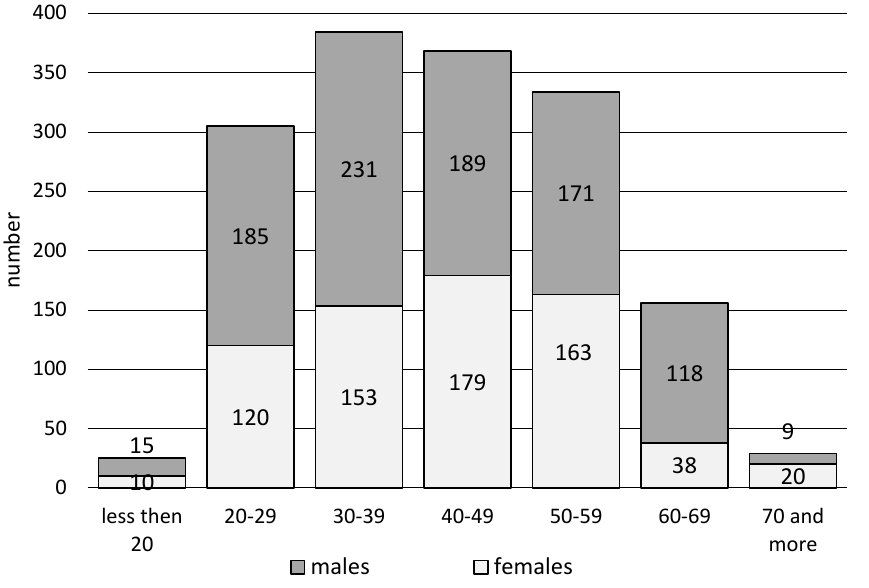
Figure 2. Interventions of emergency medical services teams in the workplace depending on the patient’s age and gender. Table 2. Interventions of emergency medical services teams in the workplace considering the pa- tient’s age and gender.